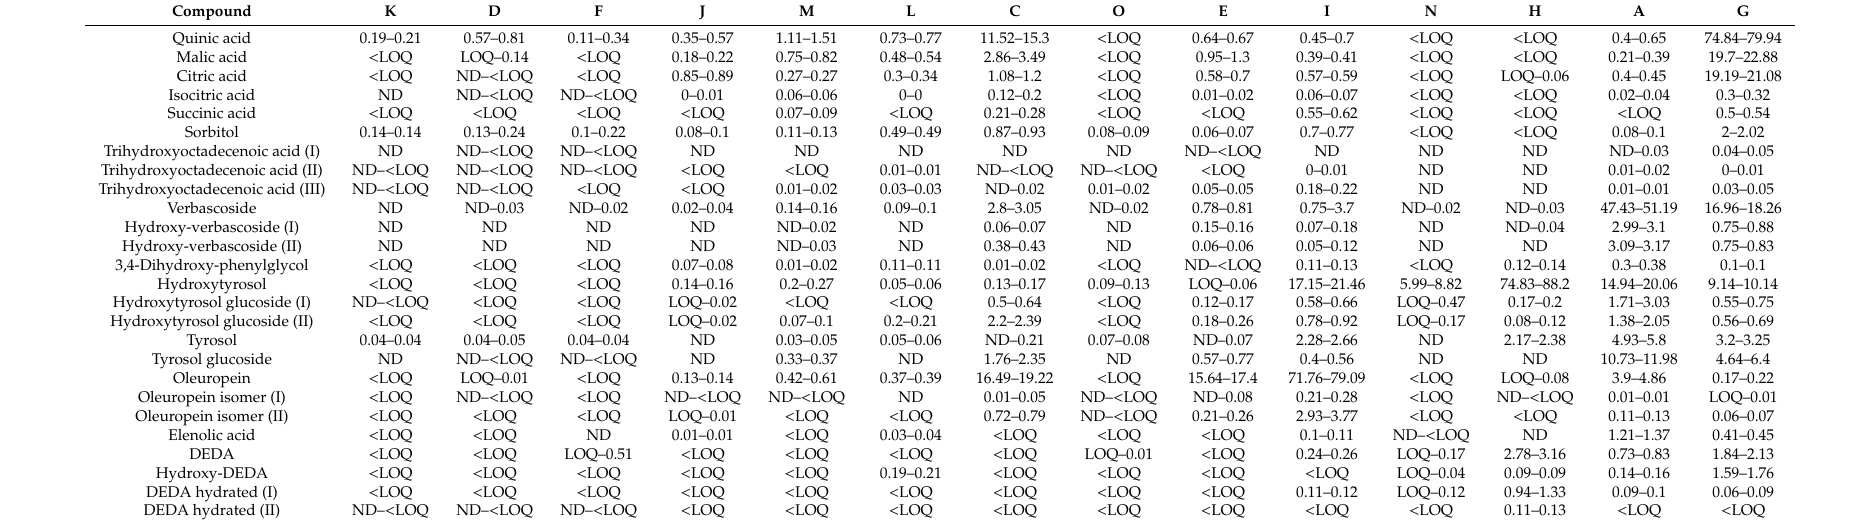
Table 3. Range of concentrations (mg / g) of the quantified compounds in study